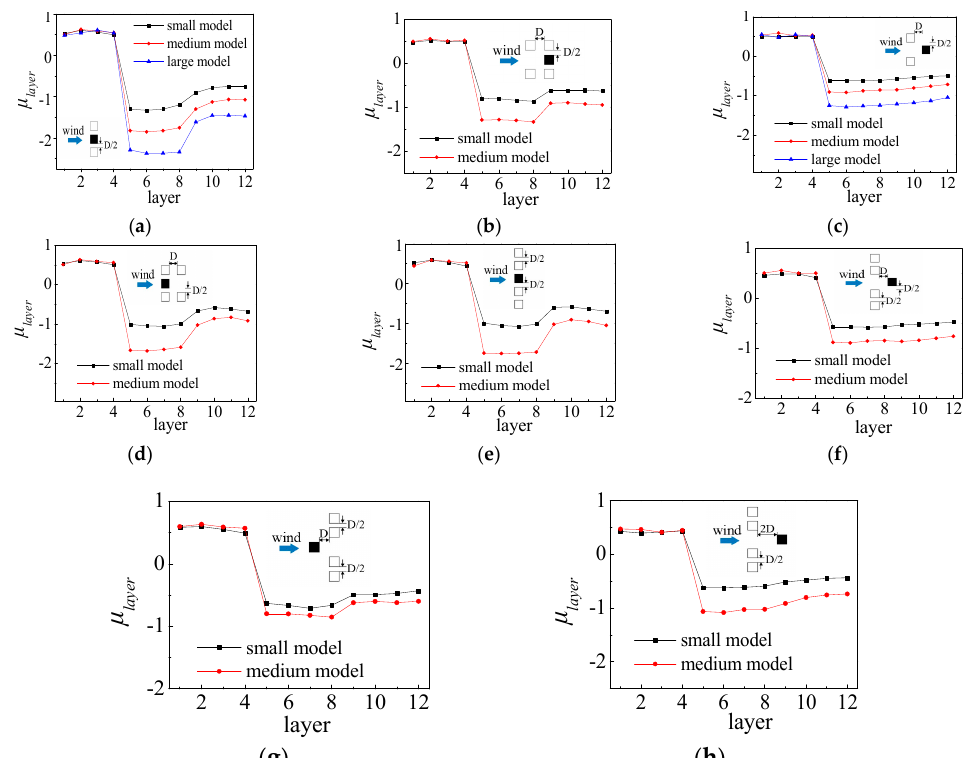
Figure 17. The mean pressure coefficient of the layers. ( a ) test condition 1; ( b ) test condition 2; ( c ) test condition 3; ( d ) test condition 4; ( e ) test condition 5; ( f ) test condition 6; ( g ) test condition 7; ( h ) test condition 8.